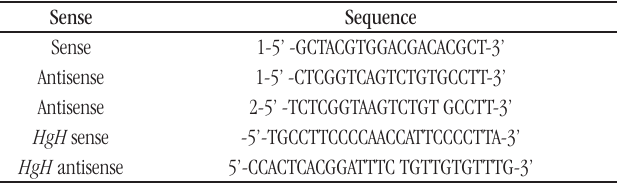
taBLE 2 − Specific primers for HLA-B*27 Sense Sequence